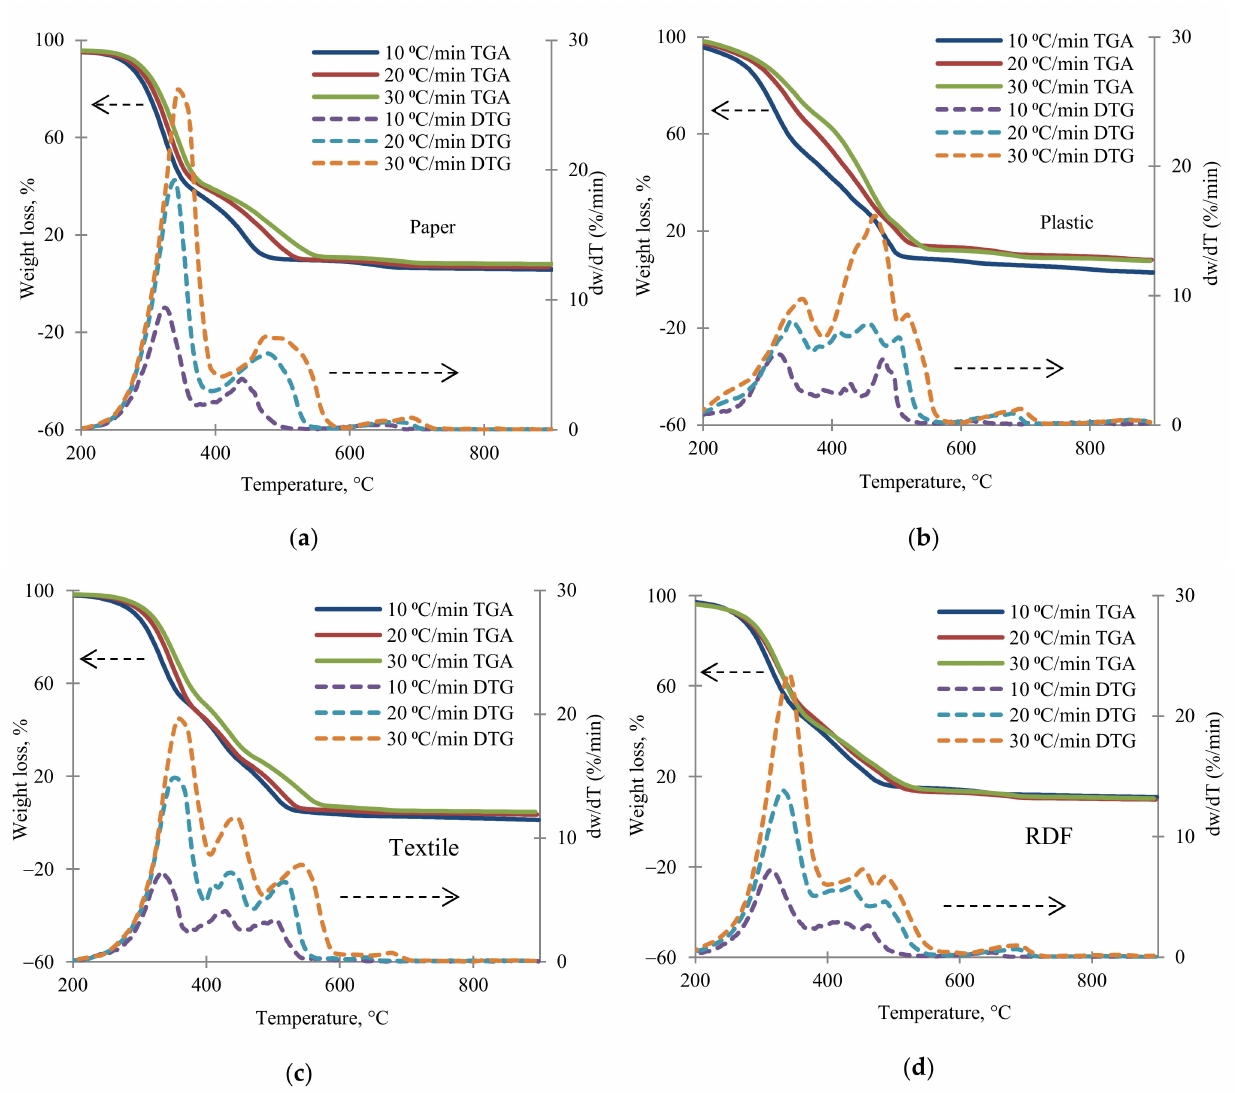
Figure 5. Effect of heating rate on TG/DTG curves of ( a ) mixed paper, ( b ) plastic, ( c ) textile, ( d )